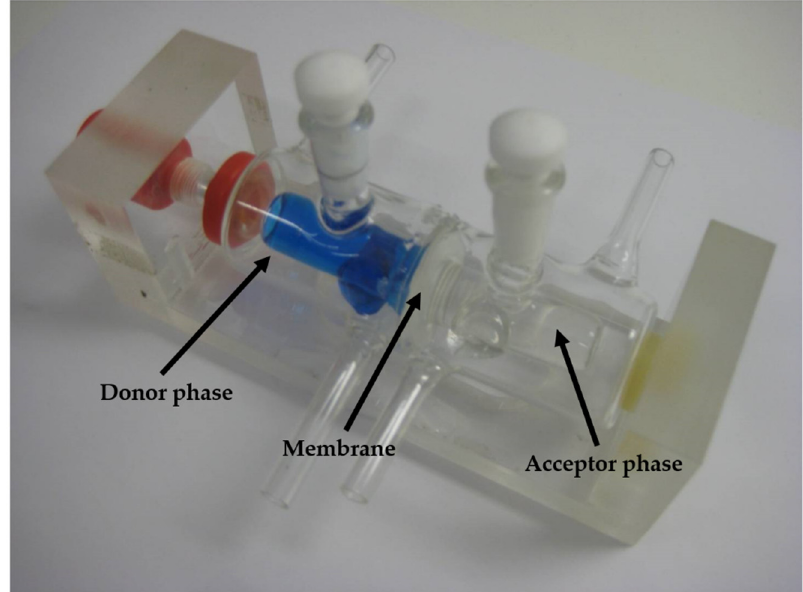
Figure 2. Illustration of Side-Bi-Side cell.